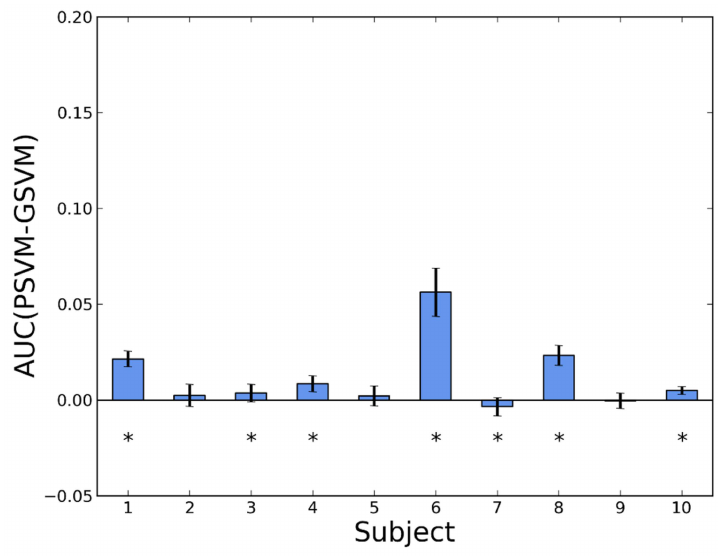
Figure 4. Difference in AUC between a personalized and a generic version of SVM (PSVM and GSVM, respectively). Whiskers represent standard deviations. Asterisks indicate p -values < 0.05 in a Wilcoxon